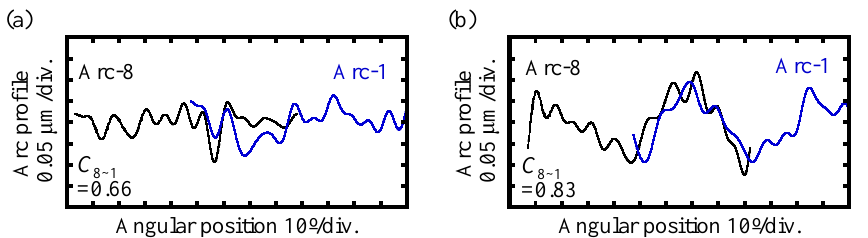
Figure 17. The relationship between Arc8 and Arc1 after the stitching operations: ( a ) Stitching of the arc-profiles obtained by the conventional setup; ( b ) Stitching of the arc-profiles obtained by the modified setup.